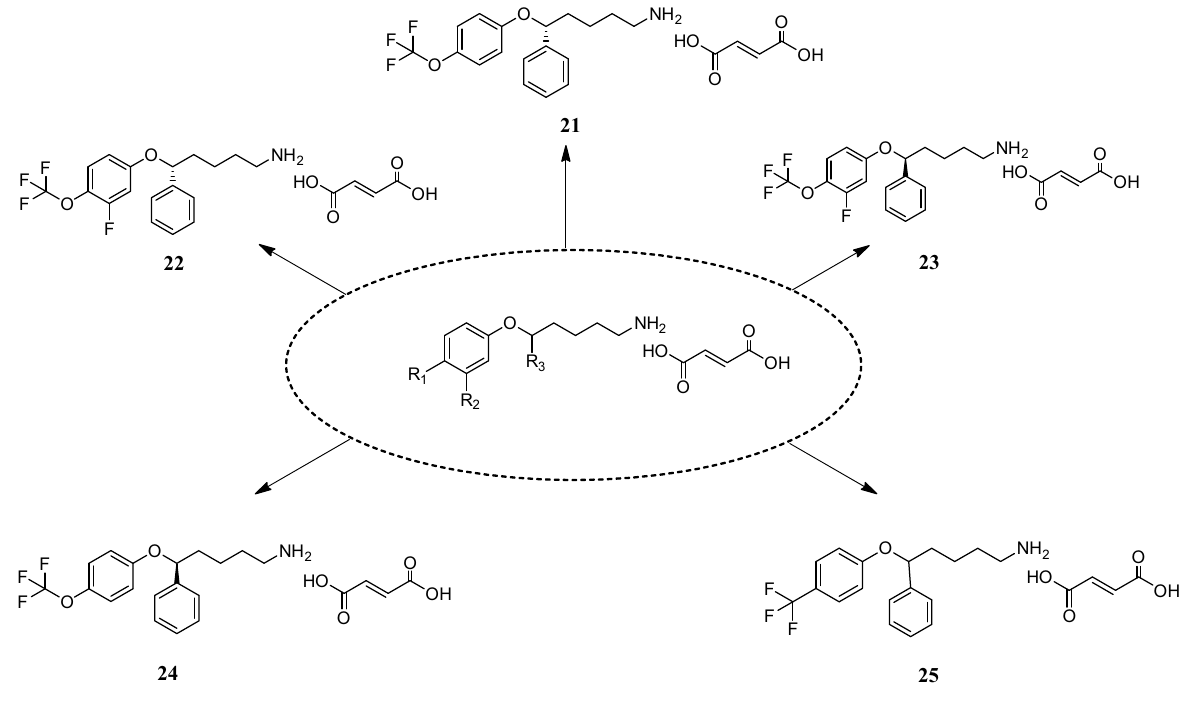
Figure 10: Chemical structures of compounds 21 –